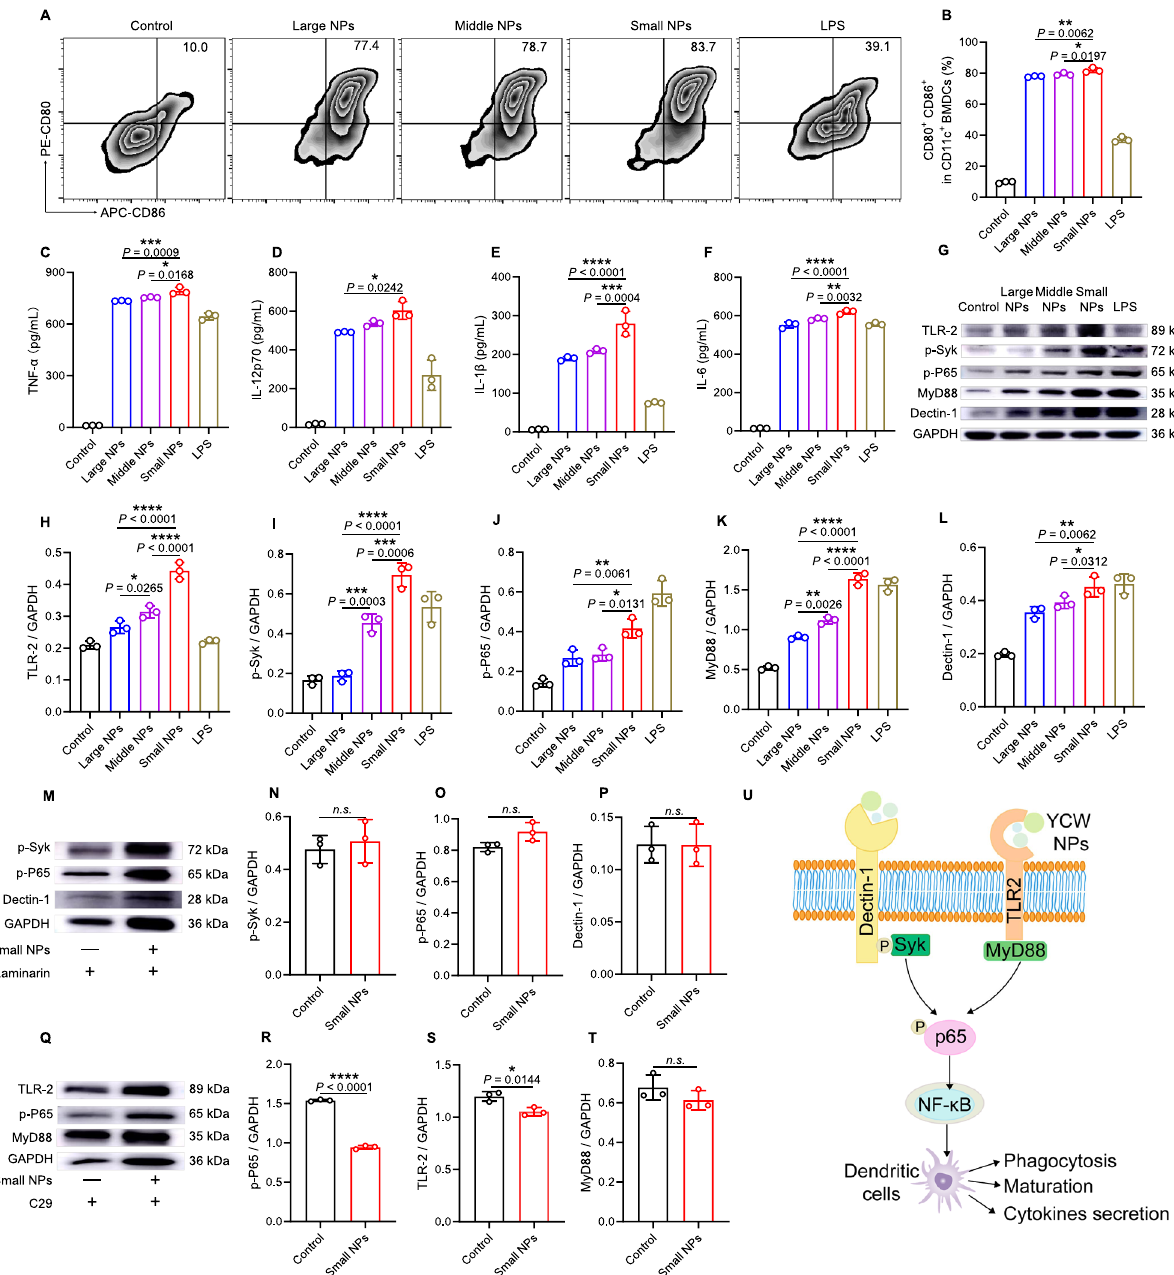
Fig. 2 Activation of dendritic cells induced by YCW NPs and its mechanism. A – B Activation of BMDCs after BMDCs incubation with different sizes YCW NPs (including large NPs, middle NPs, and small NPs) and LPS (positive control) for 24 h. A Representative dot plots of co-stimulatory molecules CD80 and CD86 expression on BMDCs and ( B ) corresponding quanti fi cation of BMDCs maturation ( n = 3). C – F Concentration of pro-in fl ammatory cytokines secreted by BMDCs after incubation with different sizes YCW NPs as indicated ( n = 3). C TNF- α ; D IL-12p70; E IL-1 β ; F IL-6. G – L Representative Western blotting result of Dectin-1/Syk pathway and TLR2/MyD88 pathway from proteins of BMDCs after incubation with three YCW NPs and LPS for 24 h ( n = 3), including ( H ) TLR2, ( I ) p-Syk, ( J ) p-P65, ( K ) MyD88, ( L ) Dectin-1. M – P After utilizing Dectin-1 competitor laminarin for 2 h, representative western blotting result of Dectin-1/Syk pathway from proteins of BMDCs after incubation with small NPs for 24 h ( n = 3), including ( N ) p-Syk, ( O ) p-P65, ( P ) Dectin-1. Q – T After utilizing TLR2 inhibitor C29 for 2 h, representative western blotting result of TLR2/MyD88 pathway from proteins of BMDCs after incubation with small NPs for 24 h ( n = 3), including ( R ) p-P65, ( S ) TLR2, ( T ) MyD88. U A scheme revealing the mechanism of YCW NPs to activate dendritic cells via a Dectin-1 and TLR2-mediated manner. All experiments were run in triplicate. Statistical signi fi cance between different groups was obtained by Student ’ s t tests (two-tailed) ( N – P , R – T ) and one-way ANOVA using the Tukey post-test ( B , C – F , H – L ). **** P < 0.0001; *** P < 0.005; ** P < 0.01; * P < 0.05. Data are means ± SD. BMDCs: bone marrow-derived dendritic cells, LPS: lipopolysaccharides. The samples for western blotting analysis derived from the same experiments and the blots were processed in